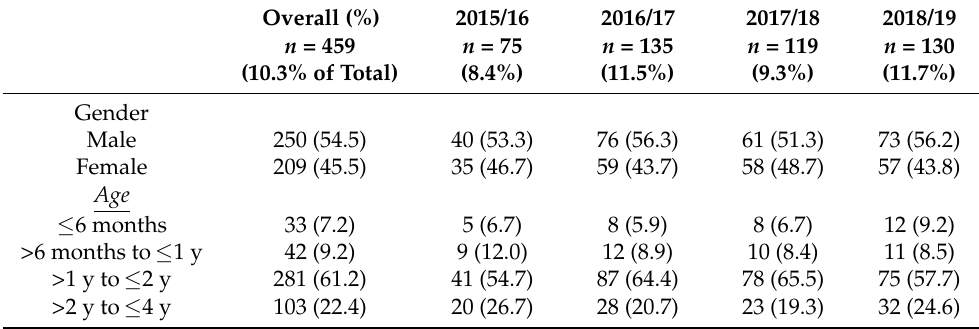
Table 3. Demographic information on HPIV-positive specimens.